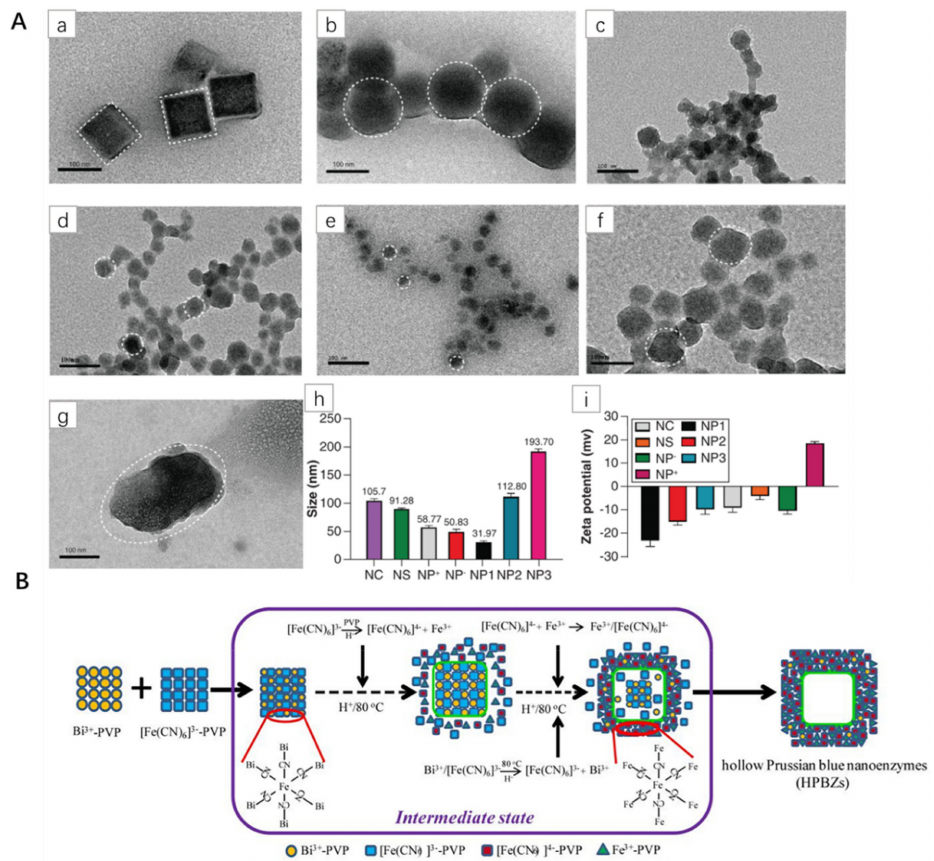
Figure 3. ( A ): Characterization of PBNPs. ( a – g ) Transmission electron microscopy indicated the shape and size of PBNPs; ( a ) NC, ( b ) NS, ( c ) NP+, ( d ) NP-, ( e ) NP1, ( f ) NP2, ( g ) NP3. ( h ) DLS size of PBNPs. ( i ) Surface charge potential of PBNPs. NC: Cuboidal PBNPs; NP: Nanoparticle; NS: Spherical PBNPs [15]. ( B ) Schematic diagram of HPBzyme formation [30]. Copyright application has been